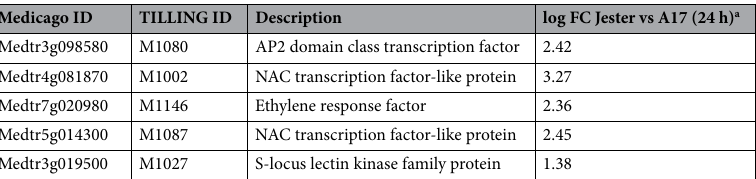
Table 3. Differentially regulated transcription factors with a premature stop-codon in the corresponding M. truncatula TILLING lines in the cultivar Jester genetic background. a The log fold-change (FC) expression difference between Jester and A17 is shown after 24 h of SAA